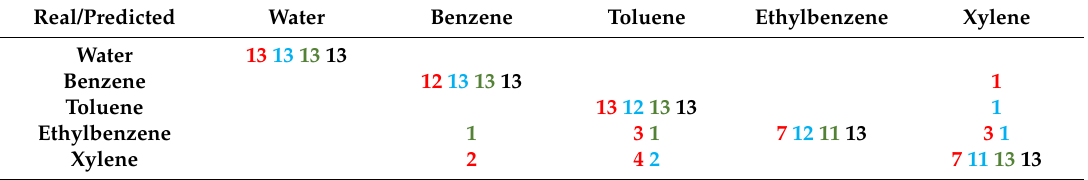
Table 2. Confusion matrix obtained in leave-one-out cross-validation (LOOCV) validation. Red: PV2; blue: PV3 (test1); green: PV3 (test2); black: